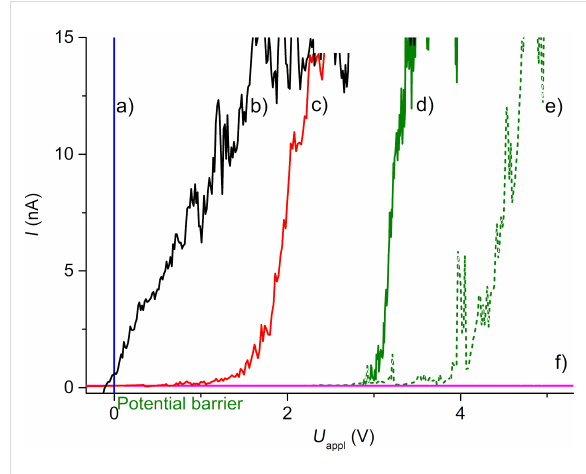
Figure 3: Single-point I – V curves performed during the mechanical contact with the Pt-coated conductive tip on a) bulk Au; b) 107 nm Au layer (both contacts on the same layer); c) 53 nm Au layer; d) and e) 19 nm Au layer before and after e-beam diffusion; f) cleaved Bi 2 Se 3